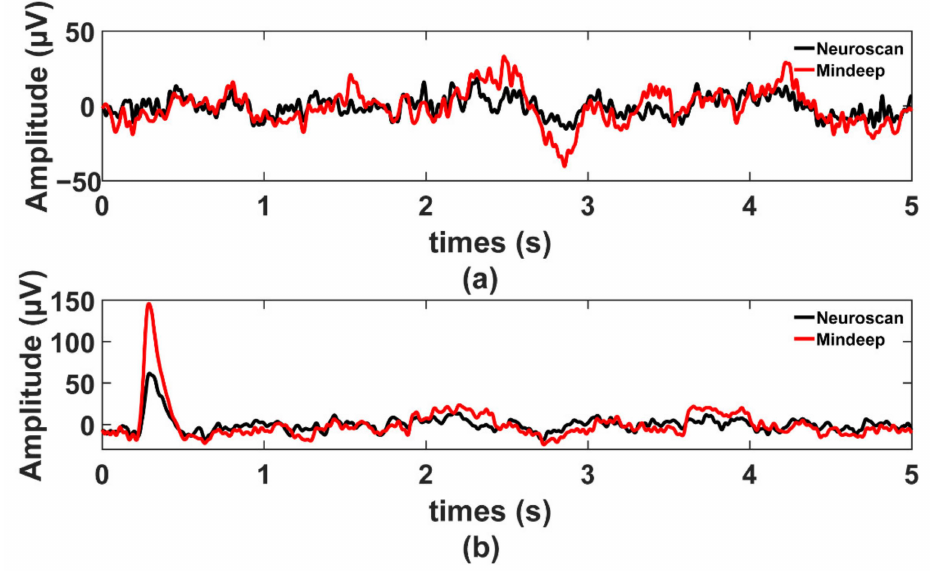
Figure 5. Resting state results. ( a ) EEG signals in EC; and ( b ) EEG signals in EO. The black line is the EEG collected by Neuroscan and the red line is the EEG collected by